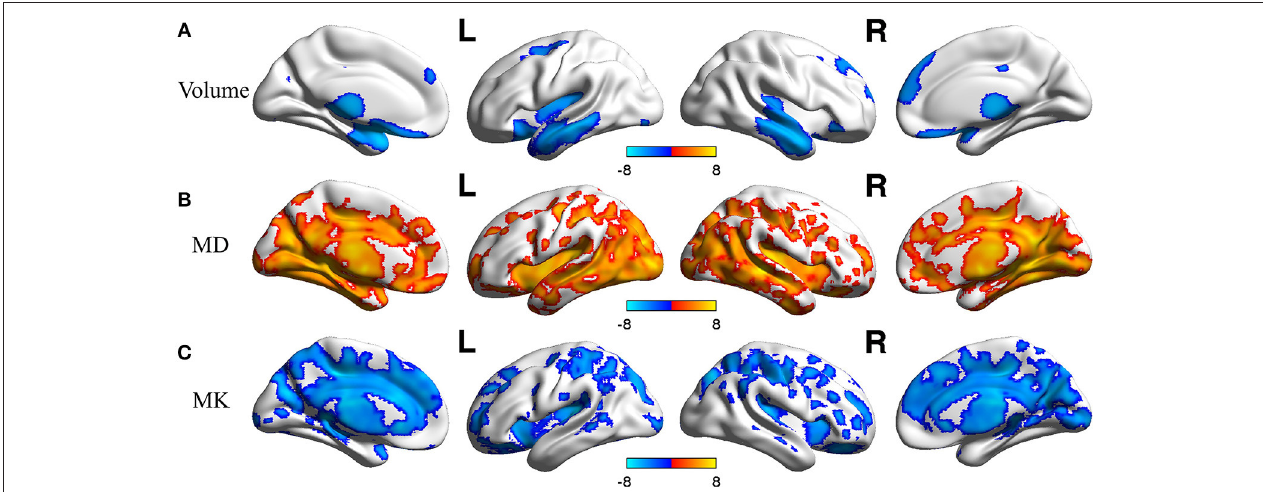
FIGURE 1 | The age-related changes of GM volume and DKI indexes at each voxel. Red color reflects increase in measures with age, and blue color reflects decrease in measures with age. L, left hemisphere; R, right hemisphere. The significant FDR corrected p -value < 0.001. (A) depicted the age-related changes of GM; (B) depicted the age-related changes of MD; (C) depicted the age-related changes of MK.